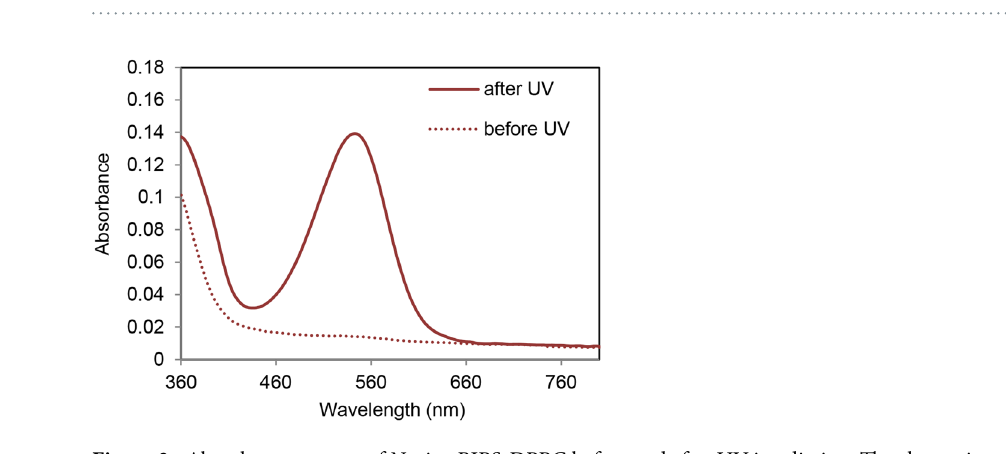
Figure 2. Structural changes of N -nitroBIPS-DPPG head group upon exposure to UV or visible light.